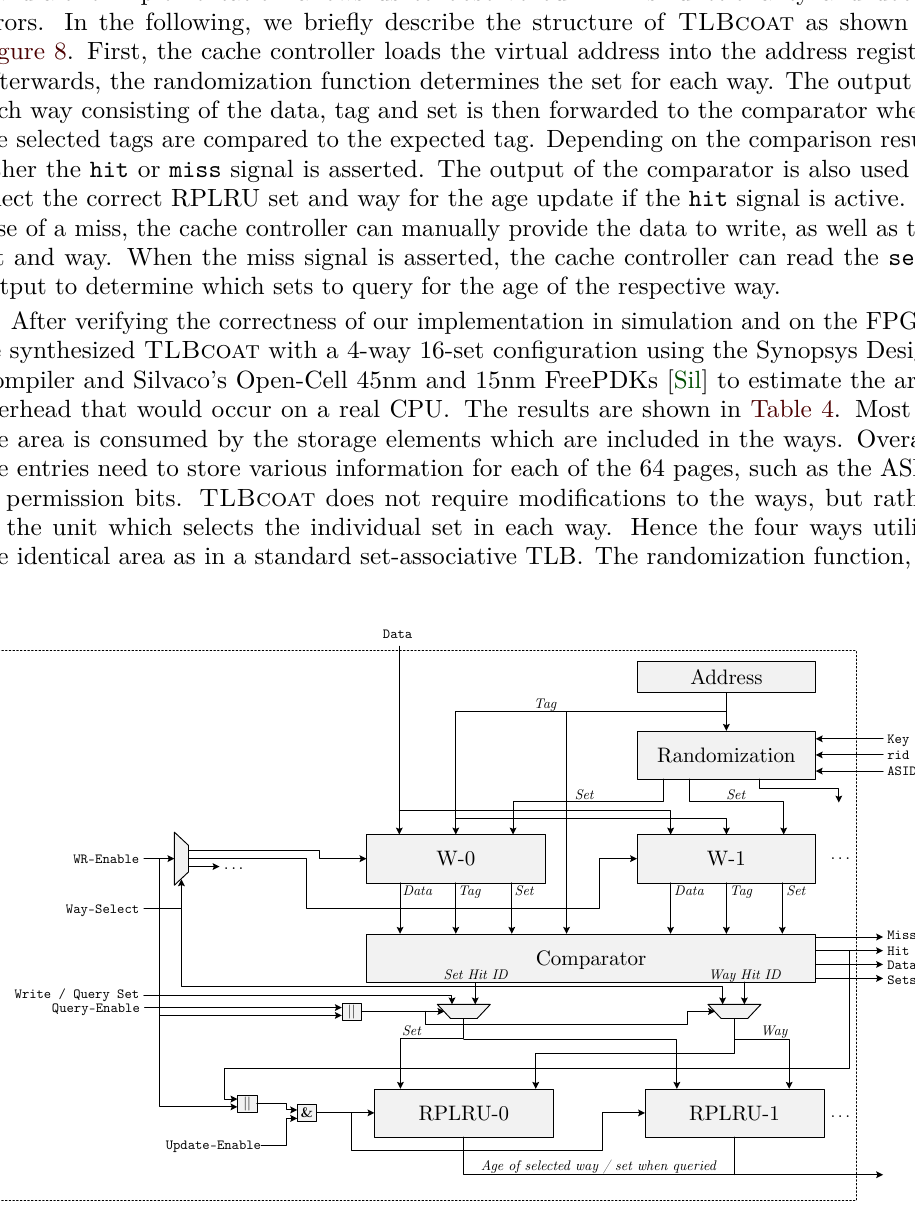
Figure 8: Simplified block diagram of the hardware implementation. For simplification the image shows a 2-set 2-way associative randomized